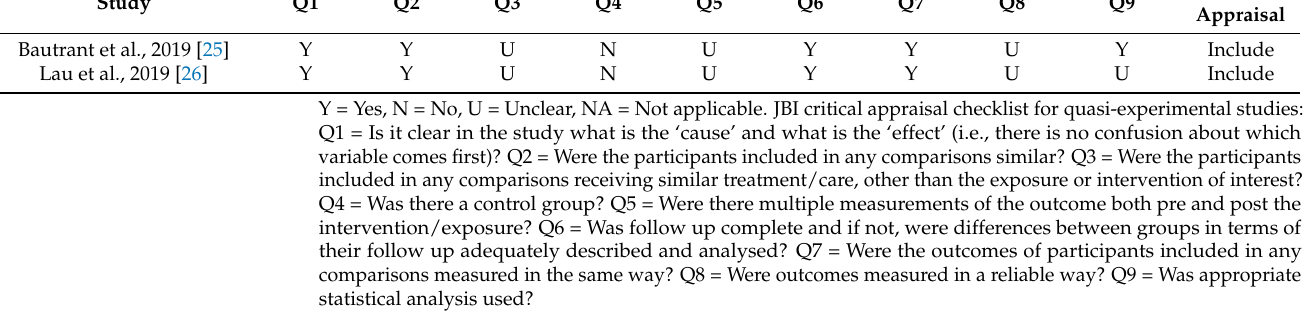
Table A9. The methodological quality assessment results of cohort studies.